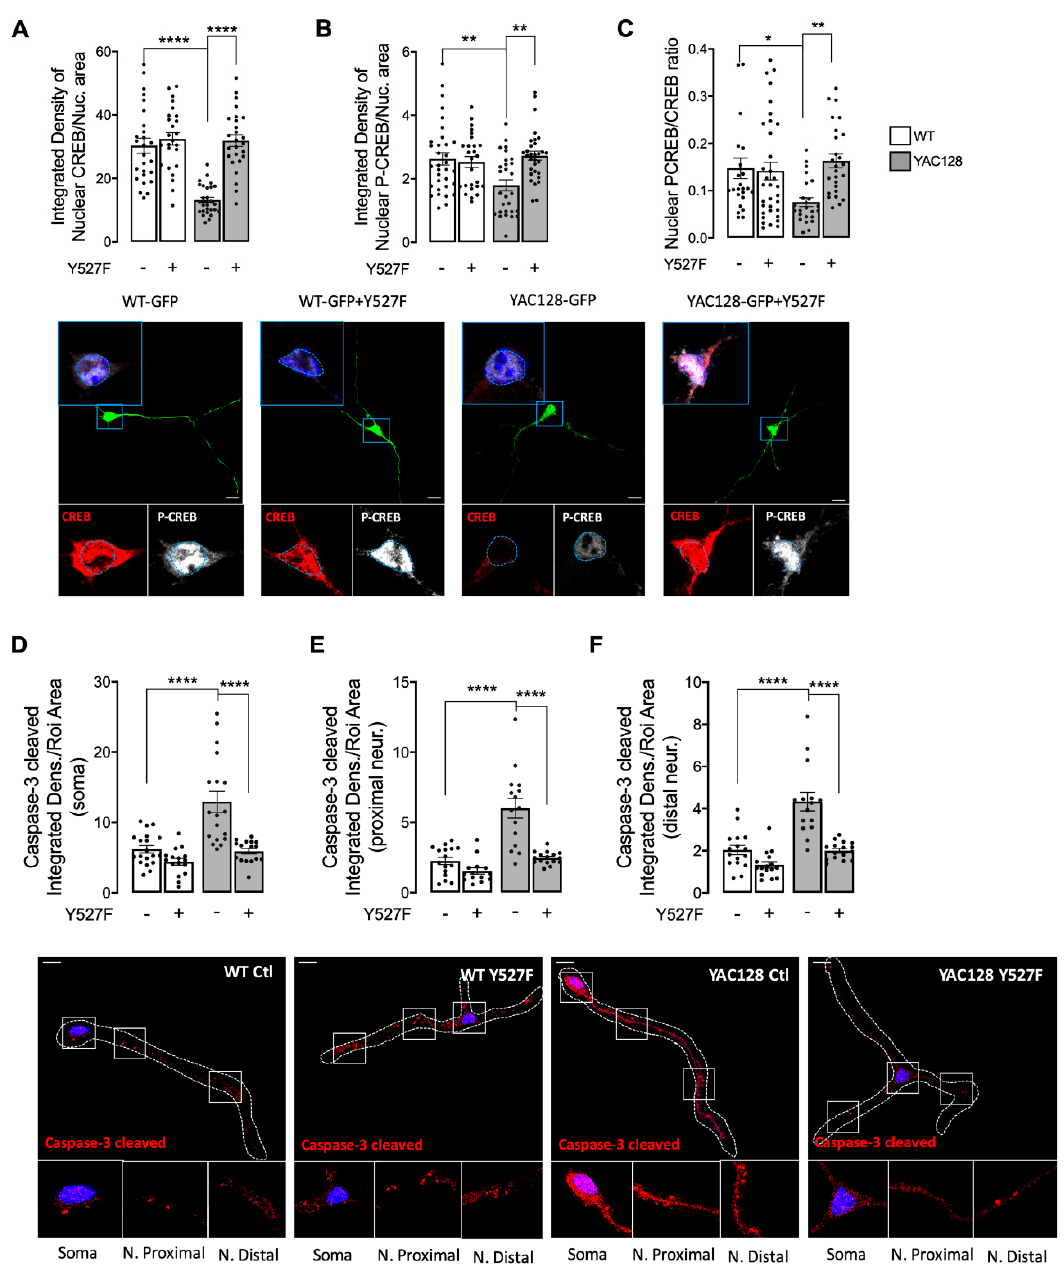
Figure 5. Overexpression of activated SKF restores CREB-activated levels and reduces caspase-3 levels in HD neurons. The nuclear levels of CREB ( A ), P(Ser133)CREB ( B ), and PCREB/CREB ( C ), as well as the levels of cleaved/active caspase-3 ( D ) in soma, proximal, ( E ) and distal ( F ) neurites were evaluated by immunocytochemistry, using confocal microscope and Image J software in WT vs. YAC128 striatal neurons. Confocal images were obtained with a 63 × objective in confocal microscope Zeiss LSM 710 (scale bar: 10 μ m). Data are presented as the mean ± SEM of 3 to 4 independent experiments considering ~6 wells/condition. Statistical analysis: * p < 0.05, ** p < 0.01, and **** p < 0.0001 versus WT or YAC128 (two-way ANOVA, followed by Sidak’s Multiple Comparison as post-hoc test).